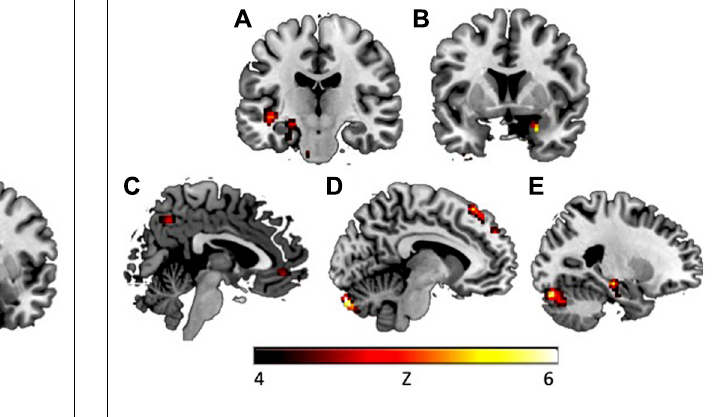
FIGURE 3 | During CS + presentation in the early extinction phase, CAPS avoidance symptoms were associated with increased activation in (A) left insula ( y = − 18), (B) right amygdala ( y = 5), (C) vmPFC ( x = 3), (D) dmPFC ( x = − 8), and (E) left hippocampus ( x = − 24) . Activations presented at p < 0.00005. vmPFC, ventromedial prefrontal cortex; dmPFC, dorsomedial prefrontal cortex. k = 6, z = 3.31, p = 0.05, SVC), and right insula (2 clusters: